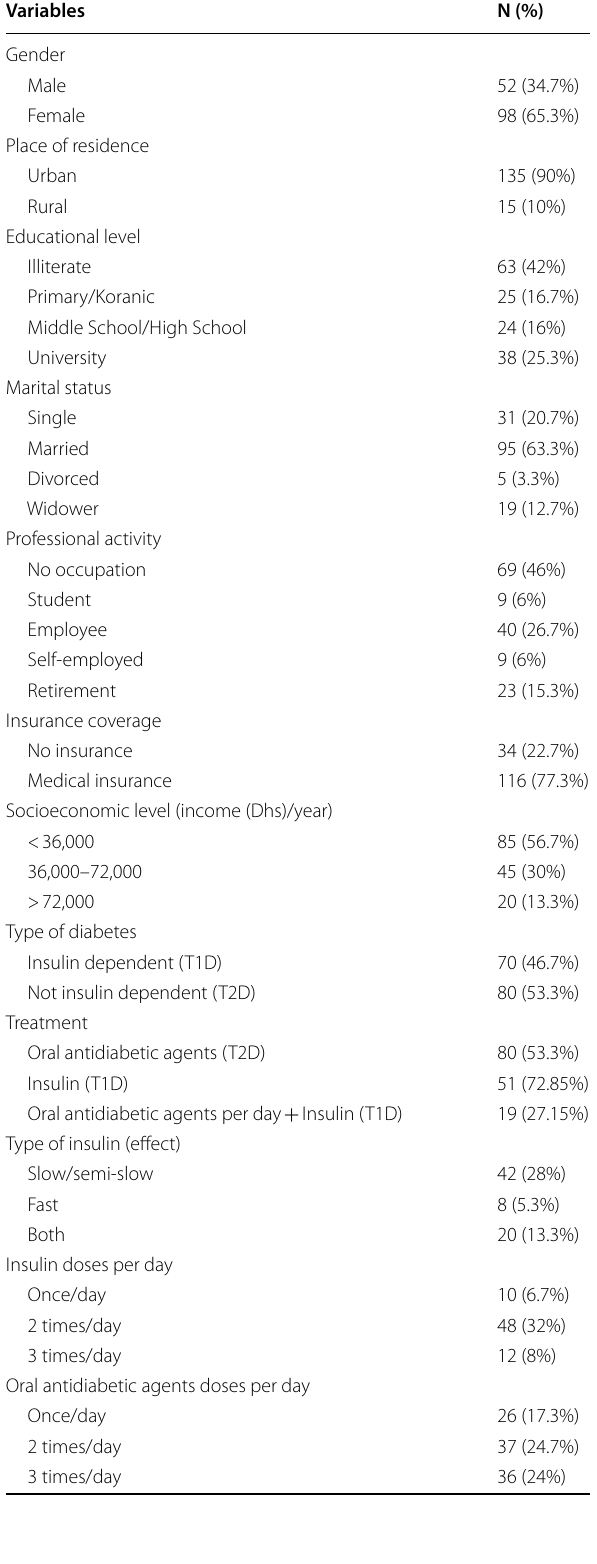
Table 1 Socio-demographic and disease characteristics of